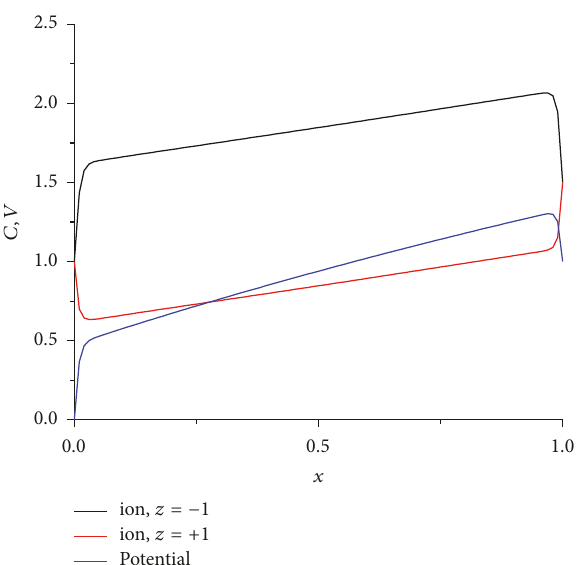
Figure 8: Uncoupled algorithm: solution for 𝛼 2 = 0.0001 [4].